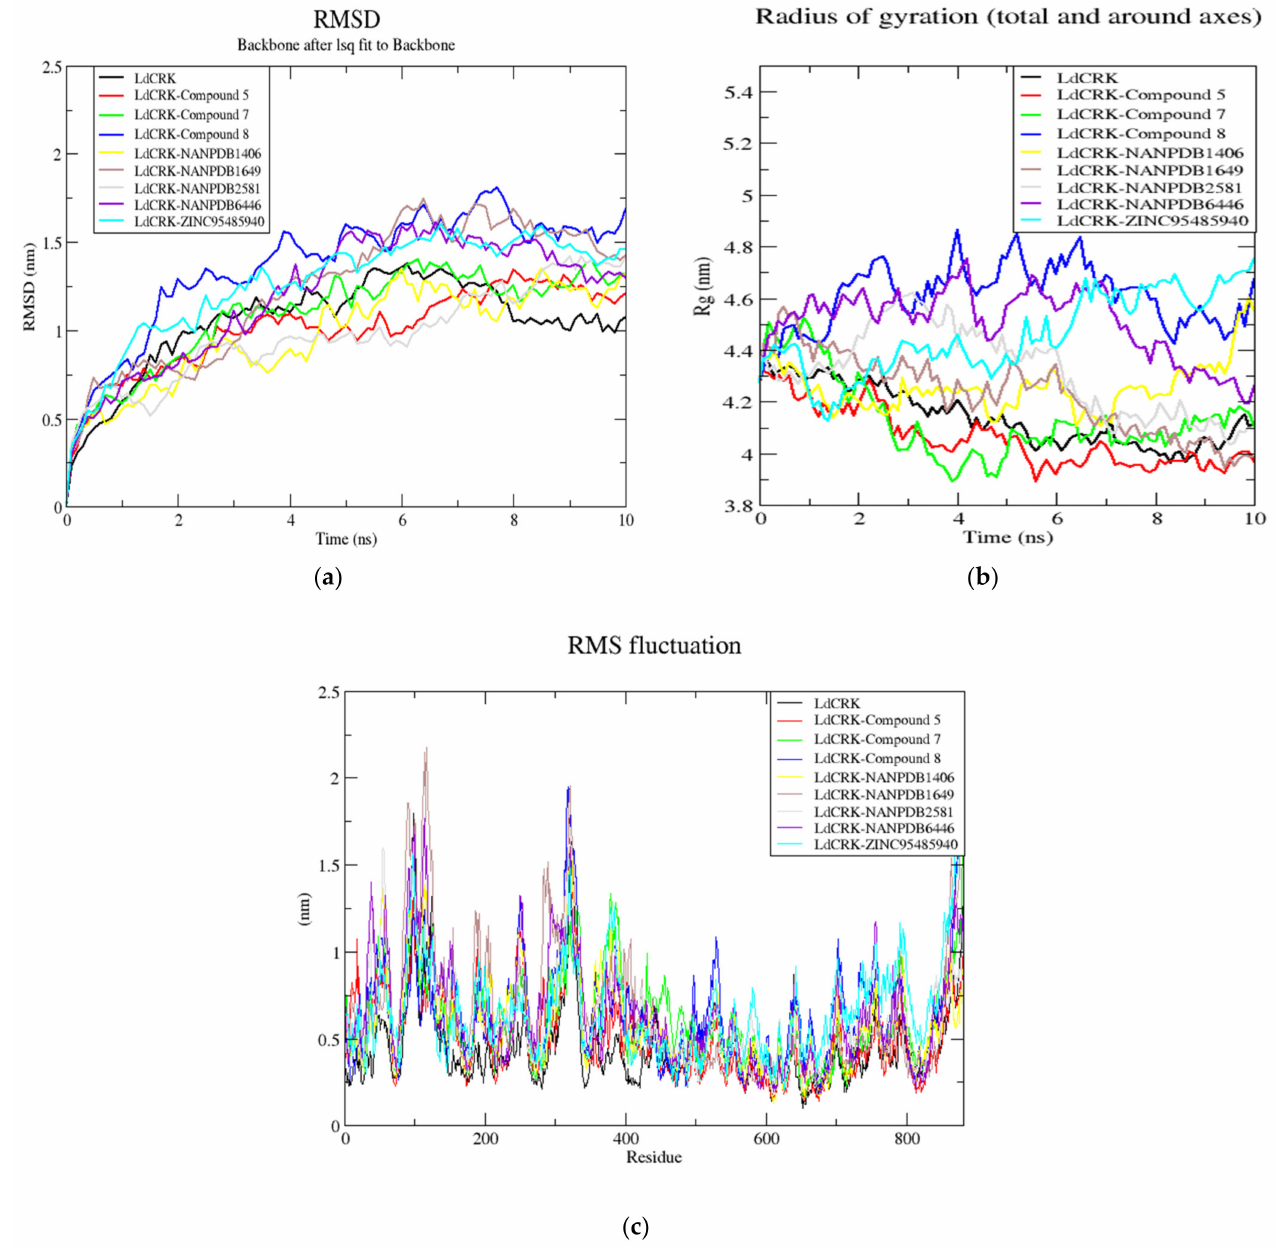
Figure 7. The root mean square deviation (RMSD), radius of gyration (Rg), and root mean square fluctuation (RMSF) graphs of the Ld CRK12–ligand complexes generated over a 10 ns molecular dynamics simulation. ( a ) RMSD versus time graph of Ld CRK12–ligand complexes; ( b ) Radius of gyration (Rg) versus time graph of Ld CRK12–ligand complexes; and ( c ) Analysis of RMSF trajectories of residues of Ld CRK12–ligand complexes. For the 3 graphs, the unbound protein ( Ld CRK12), compound 5, GSK3186899 (compound 7), compound 8, NANPDB1406, NANPDB1649, NANPDB2581, NANPDB6446, and ZINC000095485940 are represented as black, red, green, blue, yellow, brown, grey, purple and cyan,